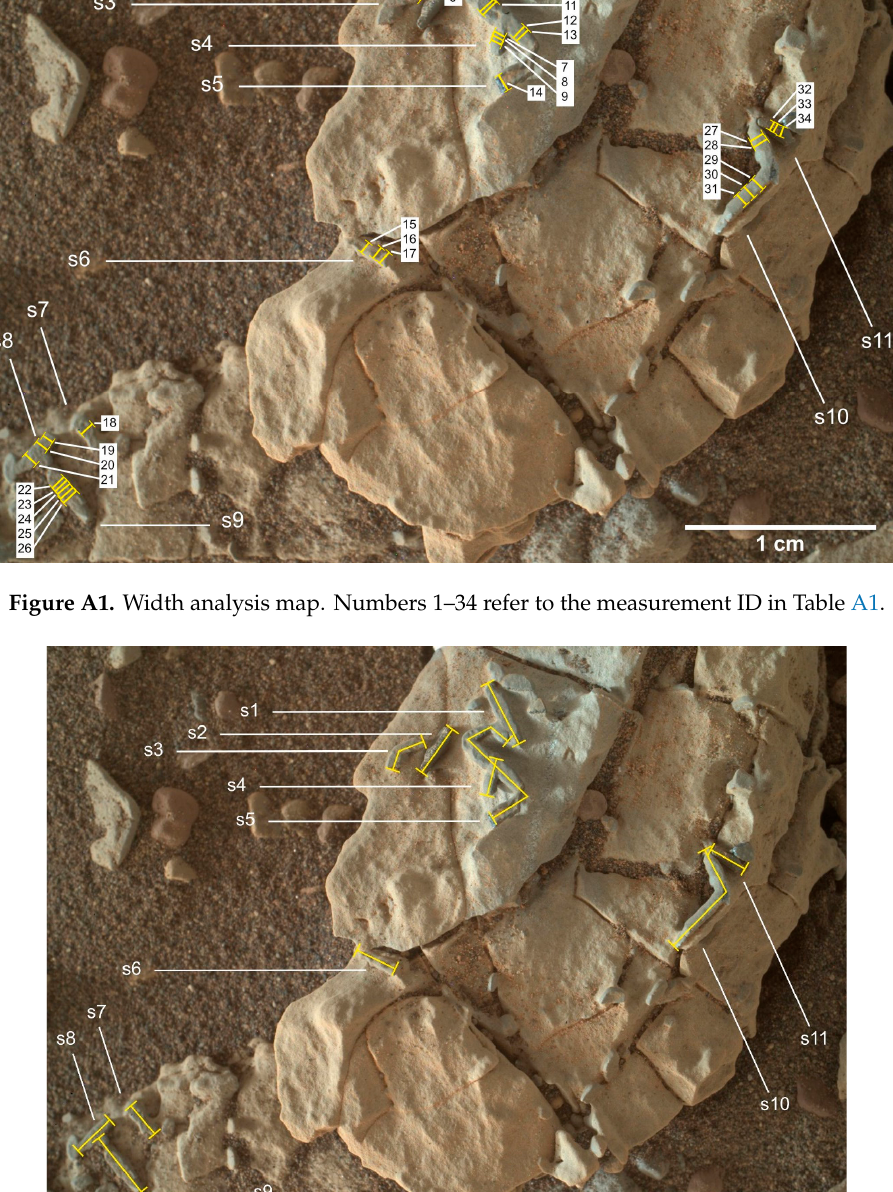
Figure A3. Angle analysis map. Table A1. (following page). Width measures of the stick ‐ like structures from Vera Rubin Ridge, Mars. See Figure A1 for location of measurements. Measurement IDMeasured Specimen Width (cm) 1